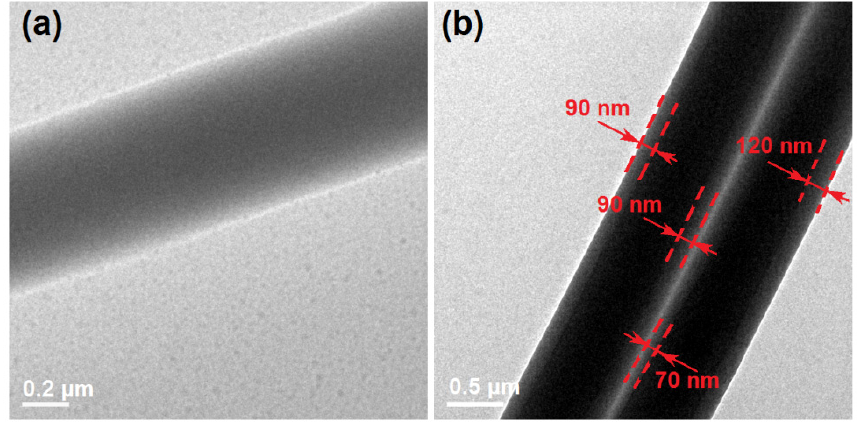
Figure 4. TEM images of the generated nanofibers: ( a ) the nanocomposites from the single-fluid electrospinning; ( b ) the core–shell nanohybrids from the coaxial electrospinning process.